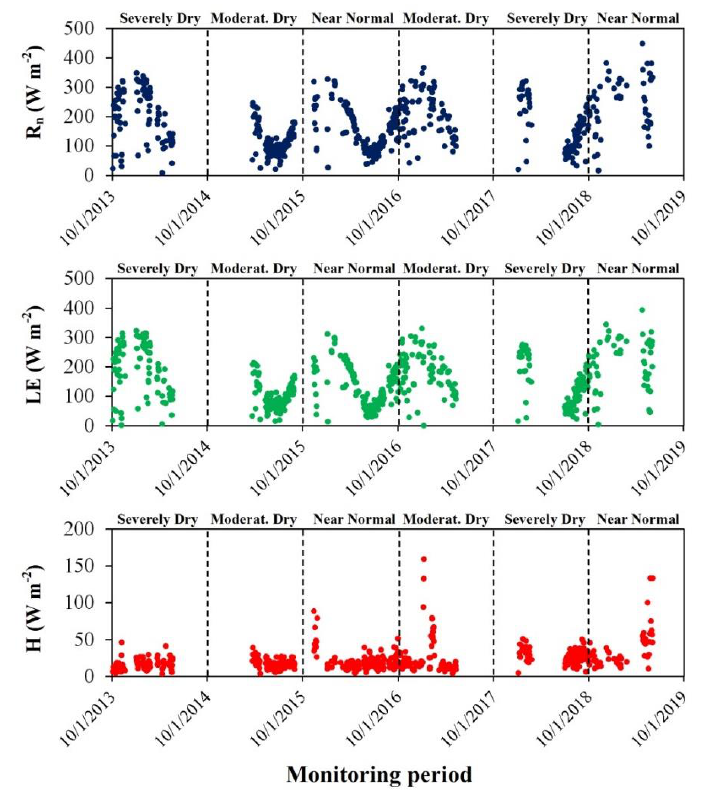
Figure 4. Seasonal variation of the net radiation (R n ) ( upper figure ), latent heat flux (LE) ( middle figure ), and sensible heat flux (H) ( lower figure ) in six hydrological years (2013 to 2019) in different weather conditions (severely dry, moderately dry, and near normal).